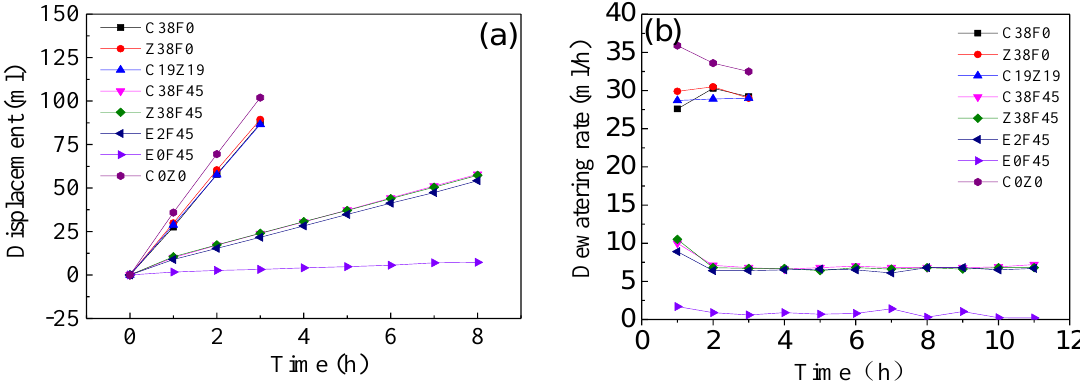
Figure 4. Displacement and drainage rate change of river sediment. ( a ) Displacement of river sediment; ( b ) Dewatering rate of river sediment.